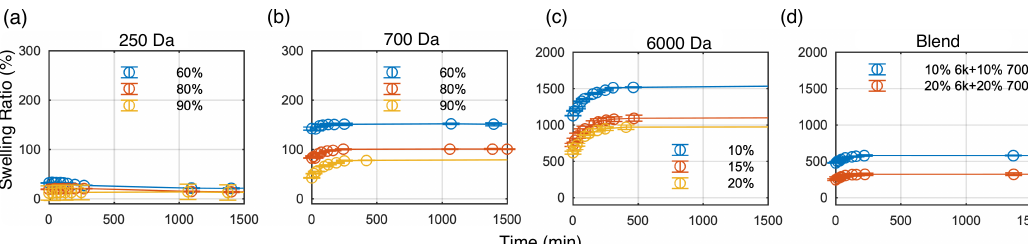
Figure 1. Swelling ratio as a function of time for ( a ) 250 Da; ( b ) 700 Da; ( c ) 6000 Da and ( d ) blend of 700 Da and 6000 Da. At t = 0, swelling ratio is determined by the weight of the hydrogel directly after fabrication with respect to the dried weight of the